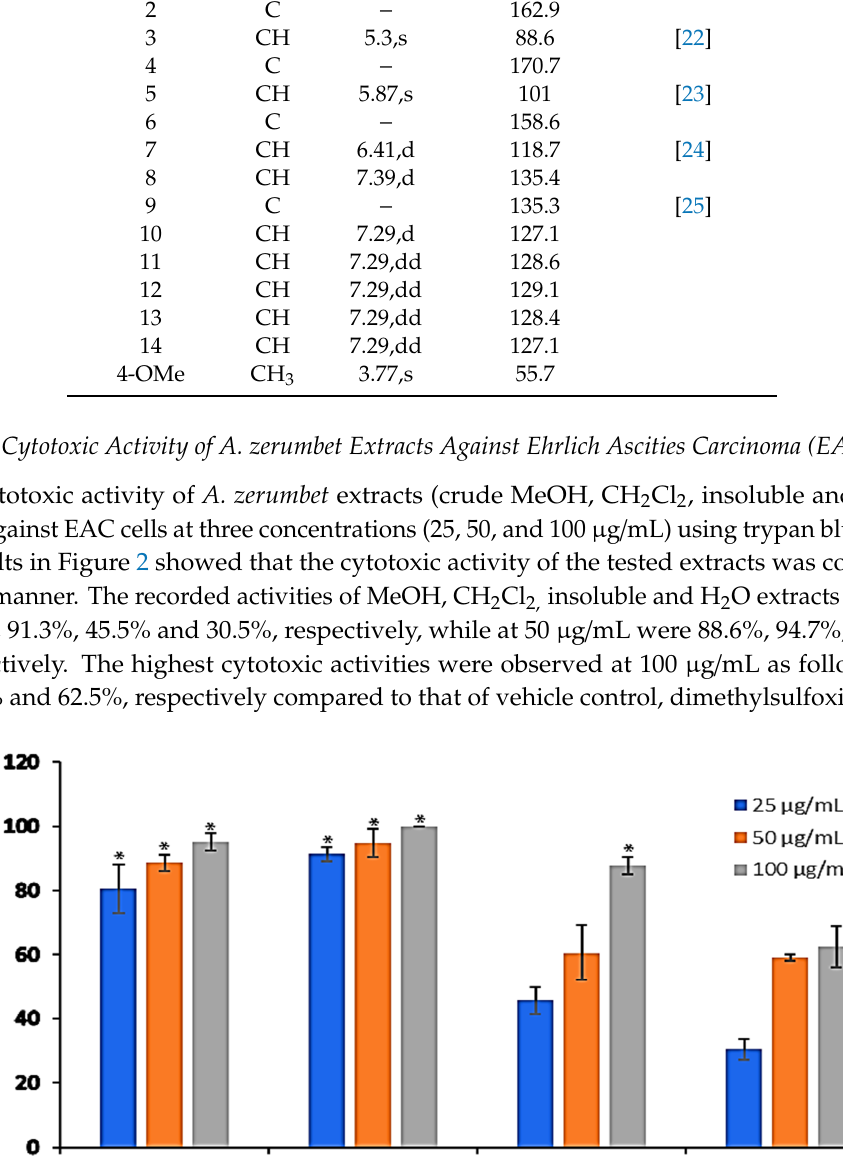
Figure 2. The in vitro cytotoxic effect of A. zerumbet extracts. The cytotoxicity of A. zerumbet extracts (MeOH, CH 2 Cl 2 , insoluble and H 2 O) was evaluated against EAC cells using trypan blue exclusion